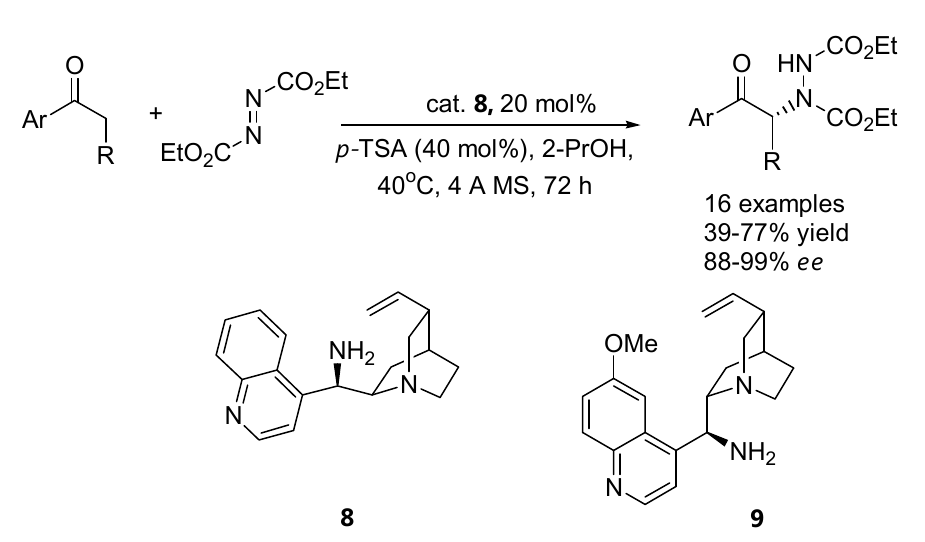
Figure 7. Direct  -amination of aromatic ketones catalyzed by primary amines derived from cinchona alkaloids [35].